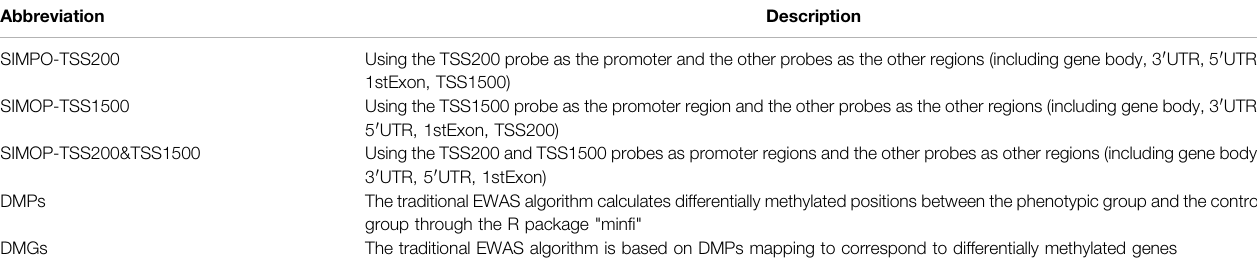
TABLE 1 | The description of the SIMPO algorithm and the traditional